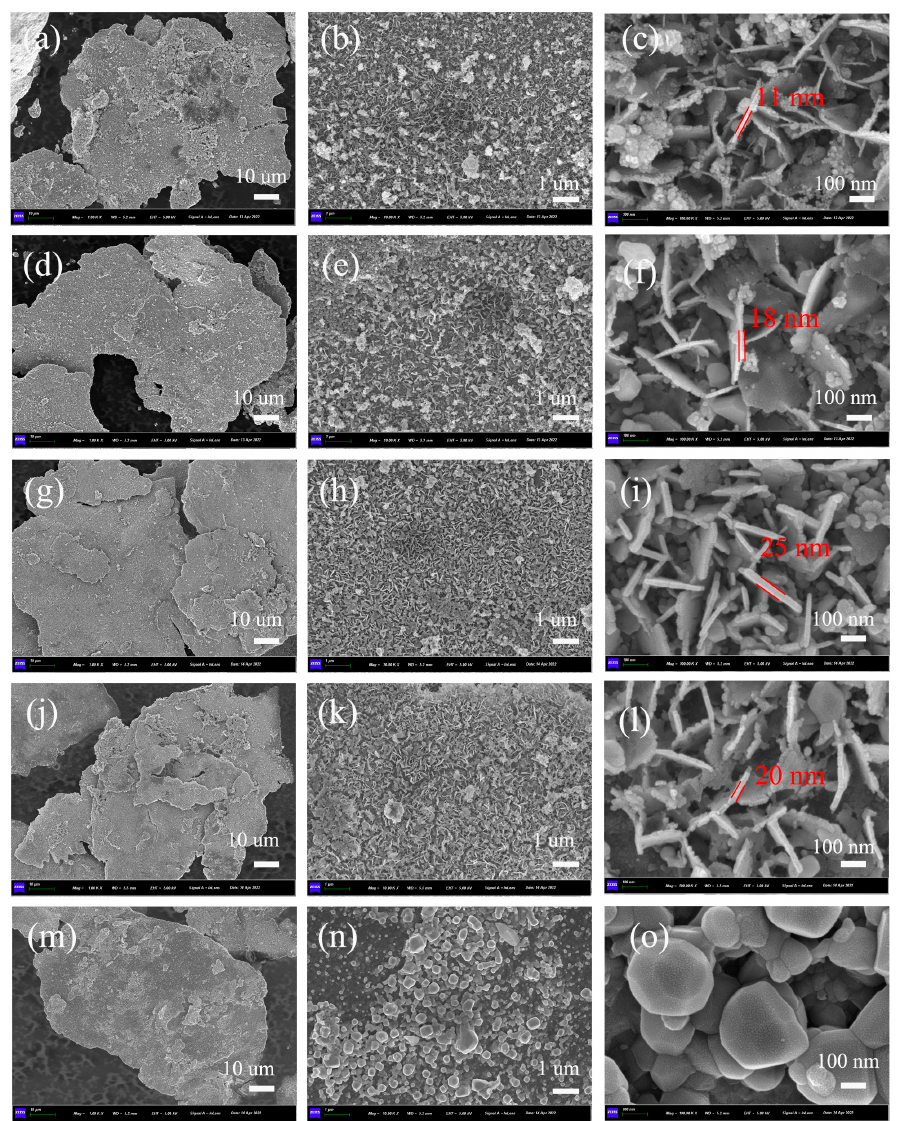
Figure 5. SEM of flaky FeSiAl composites coated with CoFe 2 O 4 ferrites annealing at ( a – c ) 650 °C, ( d – f ) 700 °C, ( g – i ) 750 °C, ( j – l ) 800 °C, ( m – o ) 850 °C.